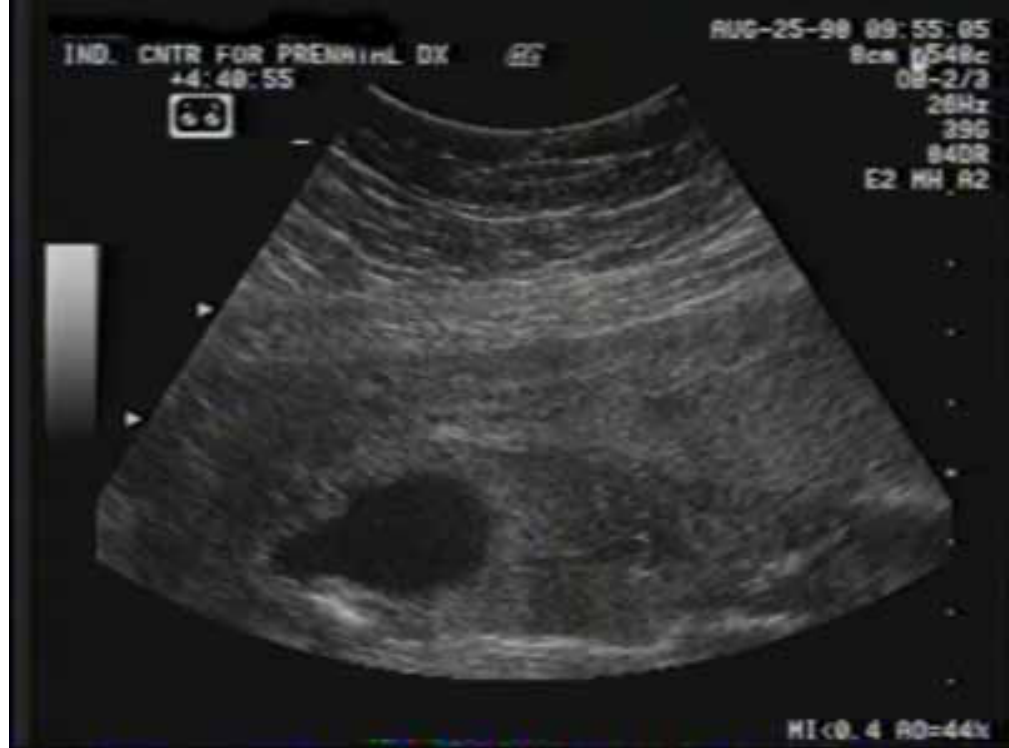
FIGURE 5. Antenatal ultrasound of fetus demonstrating “keyhole” sign indicative of the dilated bladder neck, prostatic urethra, and